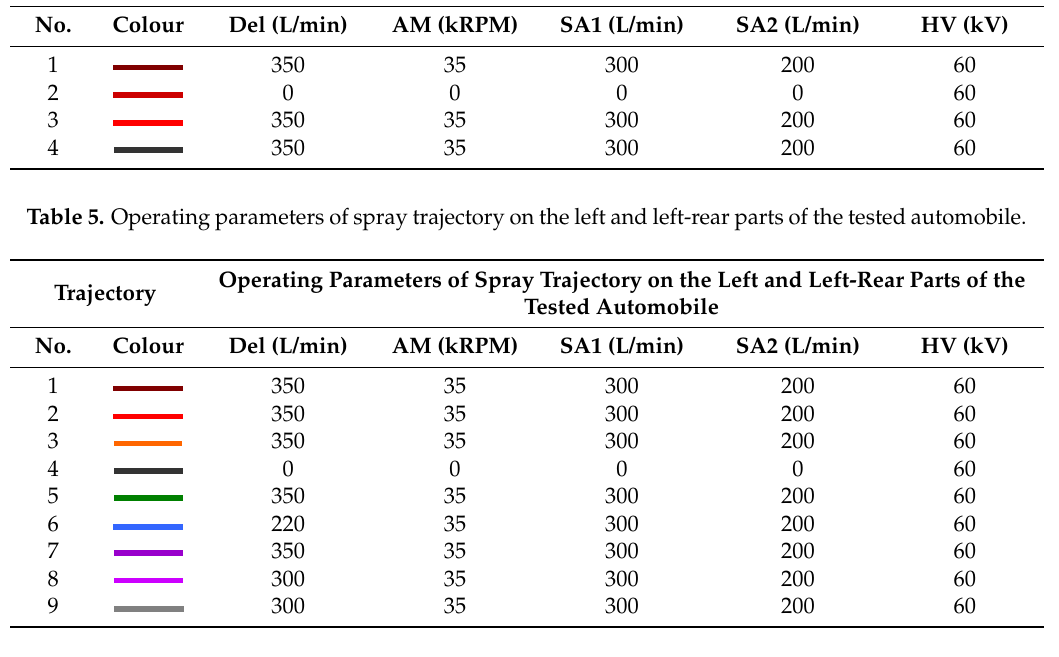
Table 4. Operating parameters of the spray ‐ painting trajectory on the roof.